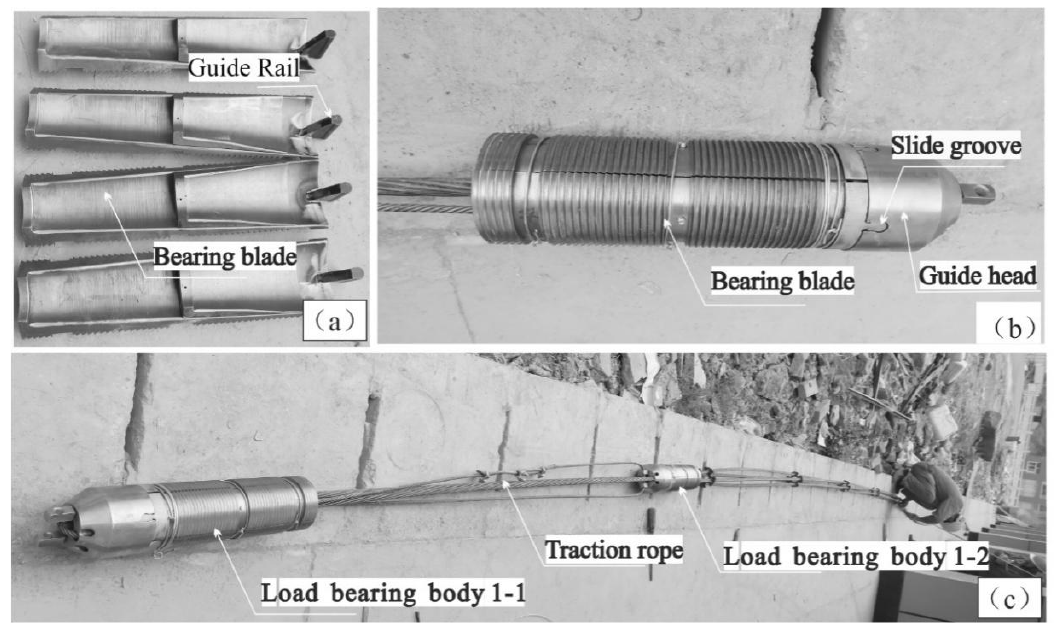
Figure 4. Making of an MSEA. ( a ) A photo of the bearing blades; ( b ) a photo of the assembled load-bearing body; and ( c ) a MSEA with a length of 23 m.